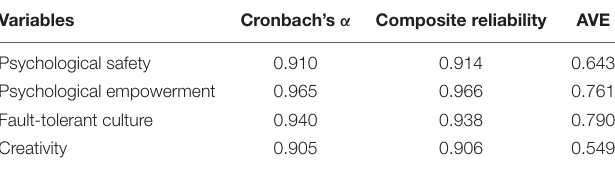
TABLE 2 | Reliability and convergent validity. TABLE 3 | Discriminant validity (Fornell-Larcker criterion).